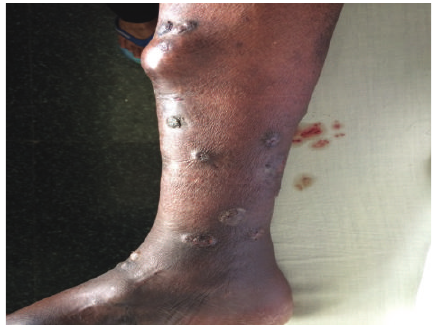
Figure 3: Photograph showing emerging subcutaneous nodule with healed lesions over the right lower